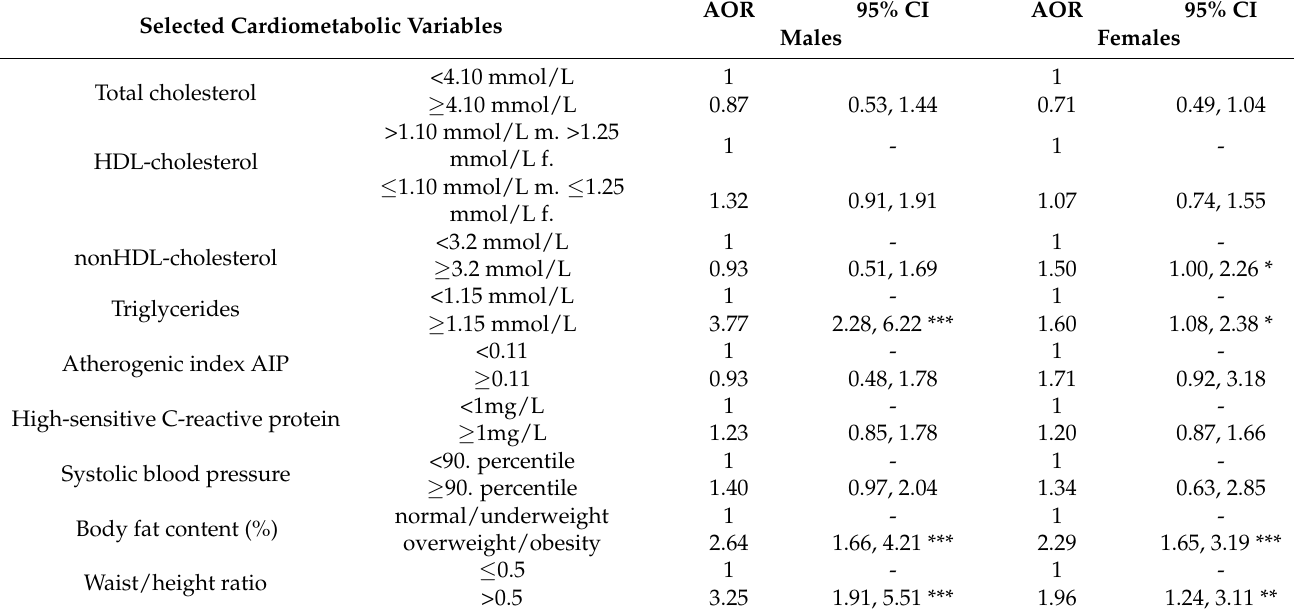
Table 3. Selected cardiometabolic variables (normal/acceptable vs. borderline/high risky) associated with insulin resistance (defined according to HOMA-IR) in males (n = 1205) and females (n = 1424)—multivariate logistic regression